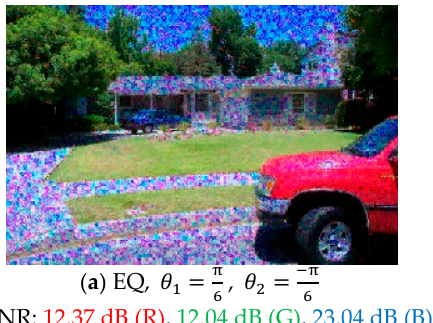
Figure 14. Demonstration of lossy transmission in the red and green planes: ( a ) EQ + AS; ( b ) EQ + AS with MDC; ( c ) QC + AS; and ( d ) QC + AS with MDC.